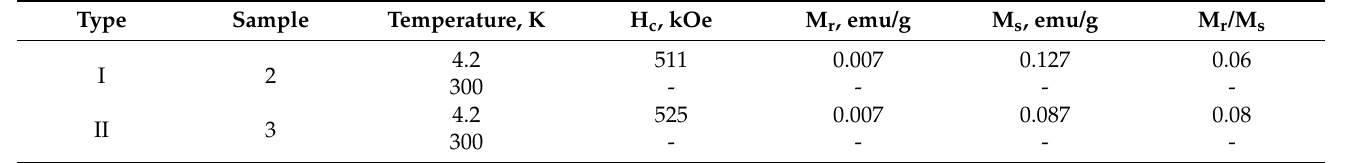
Table 4. The results of the magnetic measurements for the samples of the Ta 2 O 5 pillars with Ni